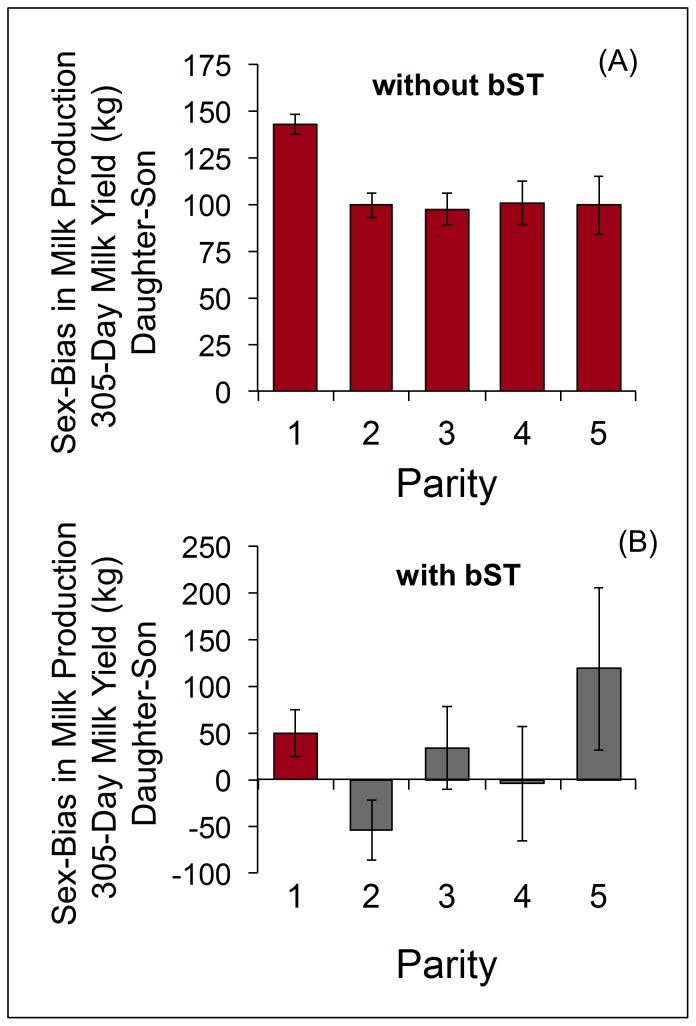
Daughters result in greater lactation productivity, and this effect is altered by exogenous somatotropin (bST) administration.Lactation records from Holstein cows (N = 2.39 million lactations) were analyzed to determine effects of calf sex, parity, use of bST, and their interactions on 305-day milk production. Calf sex influence on milk production was dependent on bST use (interaction P<0.01). A) In the absence of bST, daughters resulted in significantly greater milk production compared to sons across all parities (all P<0.001). B) Lactations influenced by bST administration failed to consistently demonstrate the daughter bias. Daughters still conferred an advantage in first-parity cows administered bST (P<0.05), but did not significantly influence milk yield in parity 2–5 cows. Values are differences of LS means ± SED.